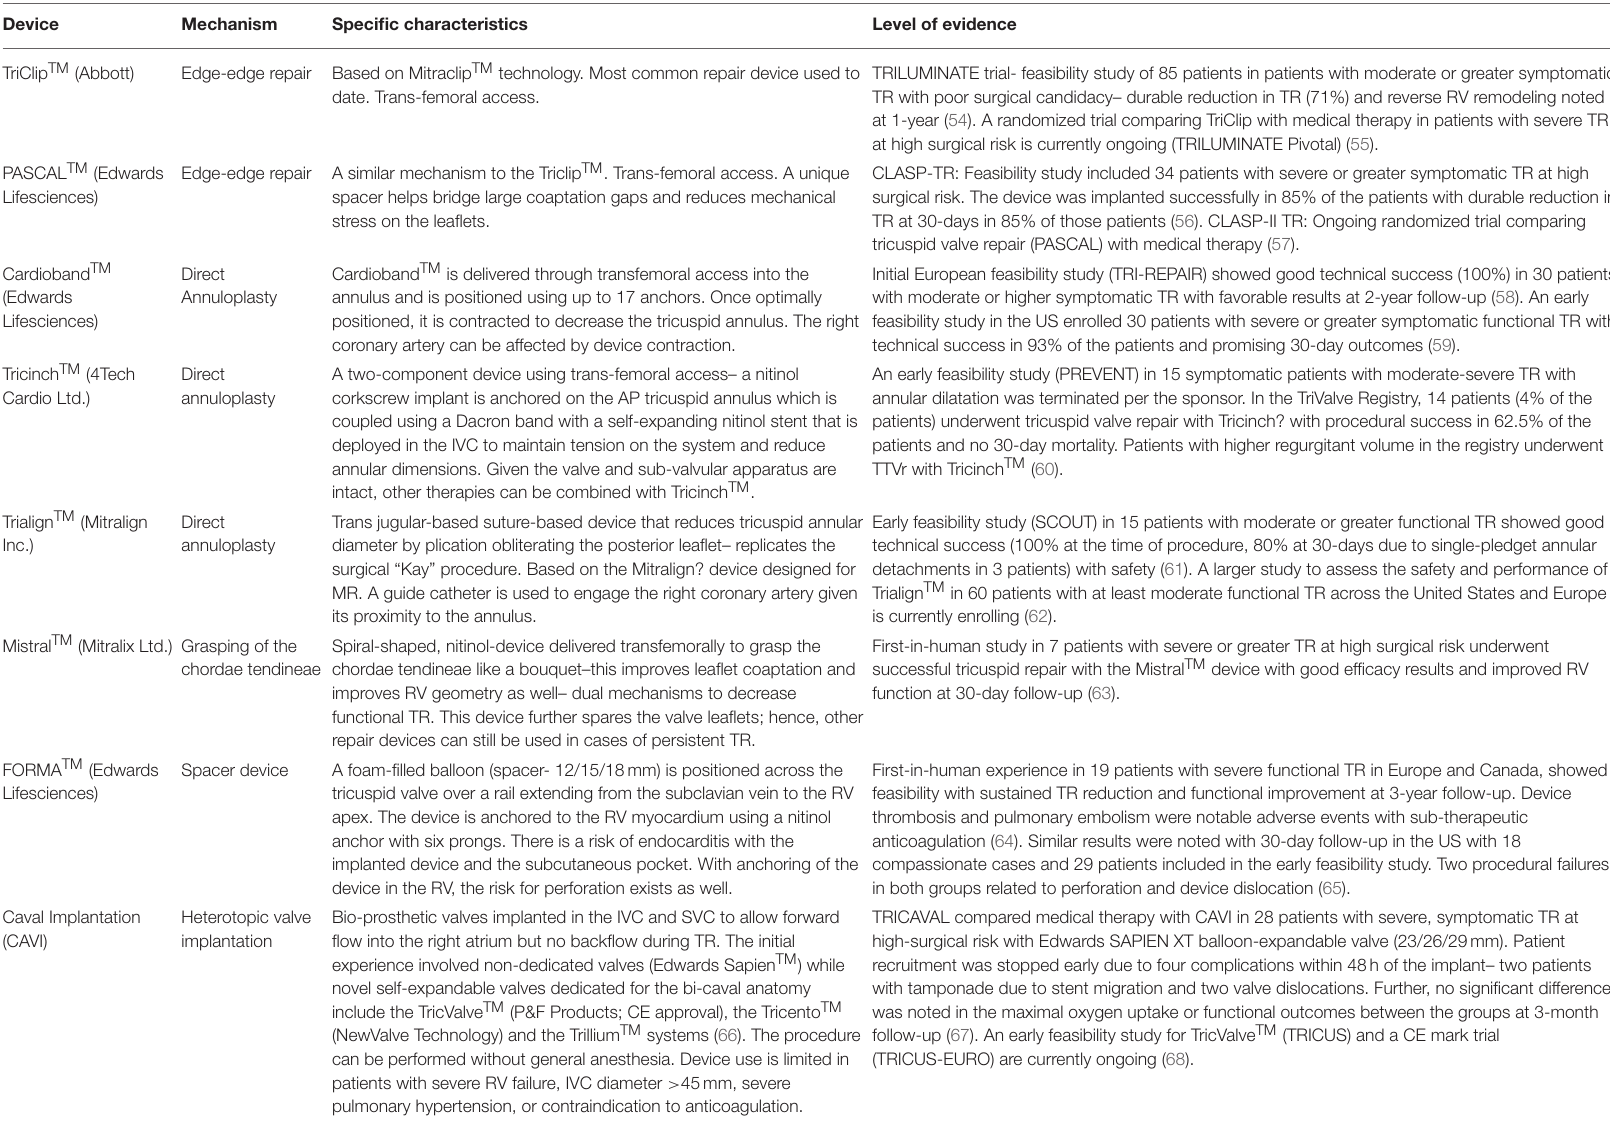
TABLE 2 | Descriptive analysis of the different Transcatheter Tricuspid Valve Repair devices with human experience.